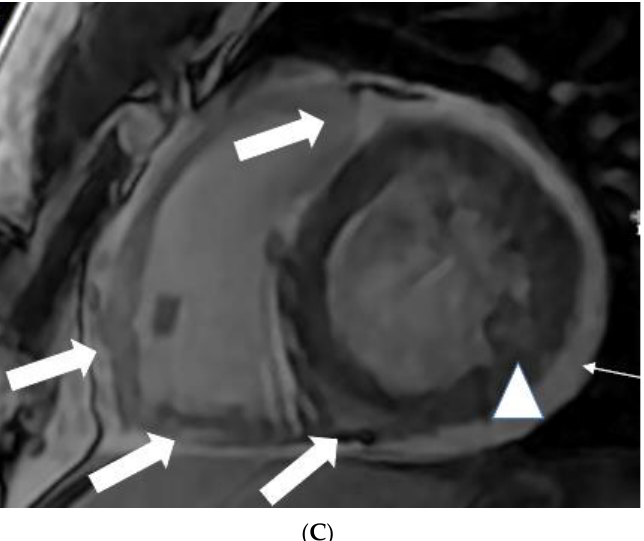
Figure 2. ( A ) A 35-year-old male with a recent history of treated tuberculous pericarditis for six months had CMR for ventricular tachycardia. Short axis mid myocardial slice, late enhancement images, shows subepicardial anterolateral (notched arrow), mesocardial mid and inferior septal (white arrow), anterior and posterior RV insertion points (curve arrow) with thickened pericardium and epicardial fat enhancement (thin arrows). Enlarged AL papillary muscle (arrowhead). ( B ) A 35-year-old male with a recent history of treated tuberculous pericarditis for six months had CMR for ventricular tachycardia. Short axis mid myocardial slice late enhancement images show all the features of ( A ) and asymmetrical enlargement of the AL papillary muscle (arrow). ( C ) A 35-year-old male with a recent history of treated tuberculous pericarditis for six months had CMR for ventricular tachycardia. Short axis mid myocardial slice late enhancement images show the RV lateral and inferior wall (arrow), superior and inferior insertion (white arrow) with epicardial fat enhancement (thin arrows). PM papillary muscle is with central enhancement (arrowhead).